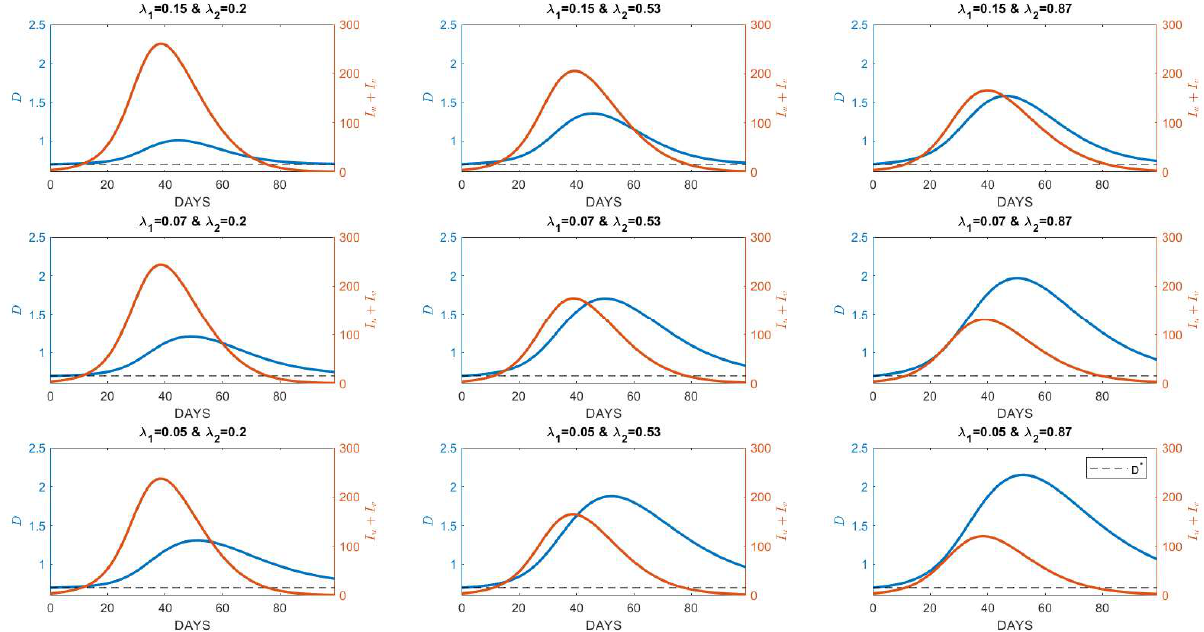
Figure 4. Numerical simulations for different values of the rate of resistance λ 1 and response to disease prevalence λ 2 . Blue lines represent the average interaction distance, while the orange lines represent the burden of cases. The values of λ 1 and λ 2 are provided for three different values (low, moderate, high); λ 2 = 0.20, 0.53, 0.87 and λ 1 = 0.05, 0.07, 0.15. All figures were generated by choosing N = 1000 and D ∗ = 0.7 m and other parameters that evaluate the values of R 0 to exceed 1; ρ = 0.5, γ 0 = 1/14, λ 1 = 1/6 .